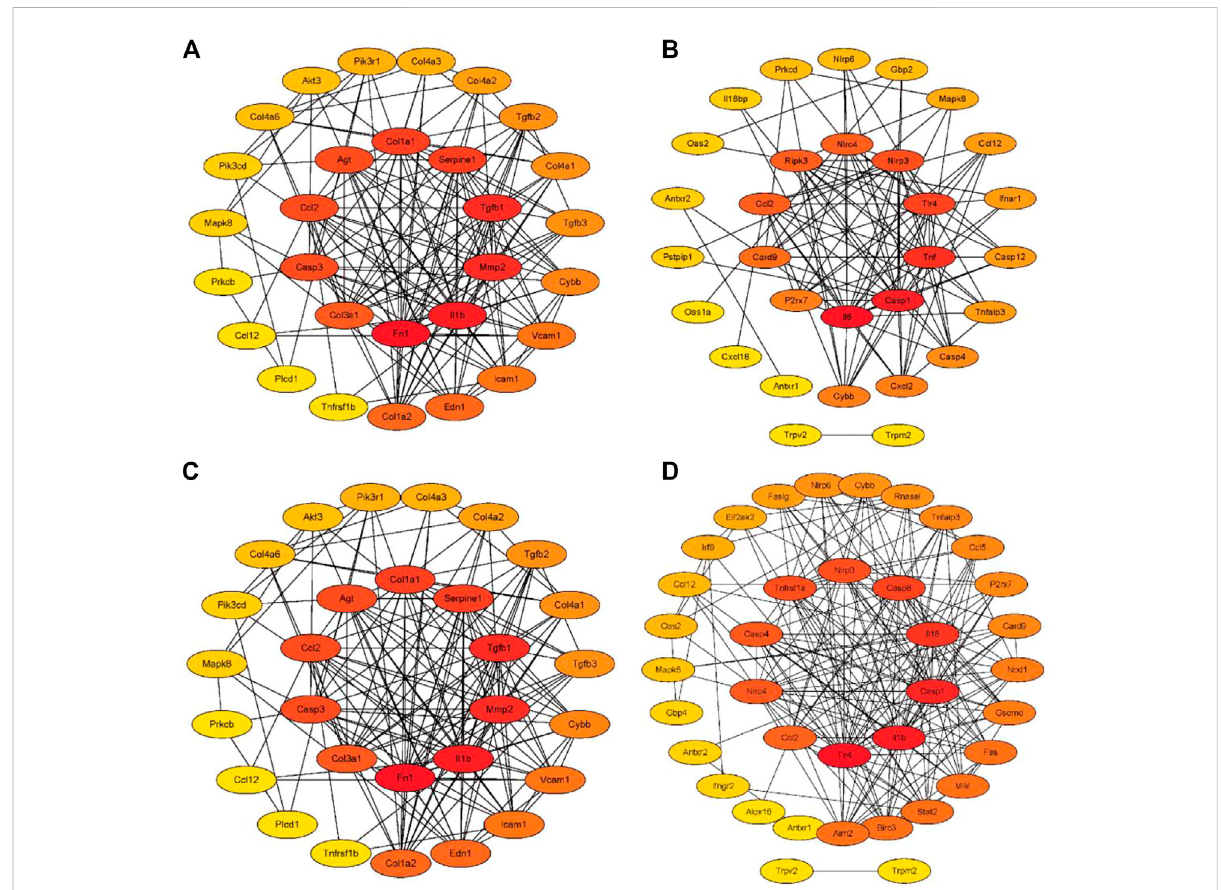
FIGURE 6 The PPI networks of RF-related DEGs in the adenine and UUO models. The intensity of the color from yellow to red indicated degree values (numberofgeneticlinks)fromlowtohigh,andtop10RF-relatedDEGsweredisplayedinthecenterofthenetwork. (A) ThePPInetworkofRF-related DEGs from the AGE-RAGE pathway in the adenine model. (B) The PPI network of RF-related DEGs from NOD-like receptor pathway in the adenine model. (C) The PPI network of RF-related DEGs from the AGE-RAGE pathway in the UUO model. (D) The PPI network of RF-related DEGs from the NOD-like receptor pathway in the UUO